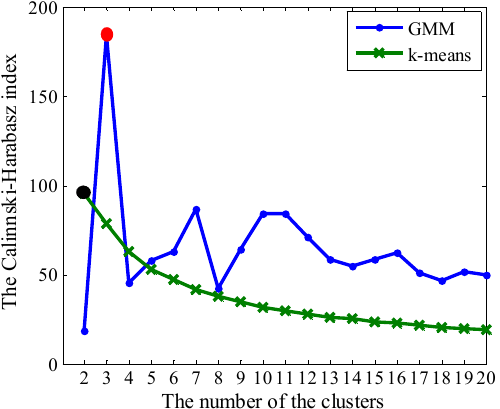
Figure 3. The comparison of PV Calinnski-Harabasz index of two different clustering methods.